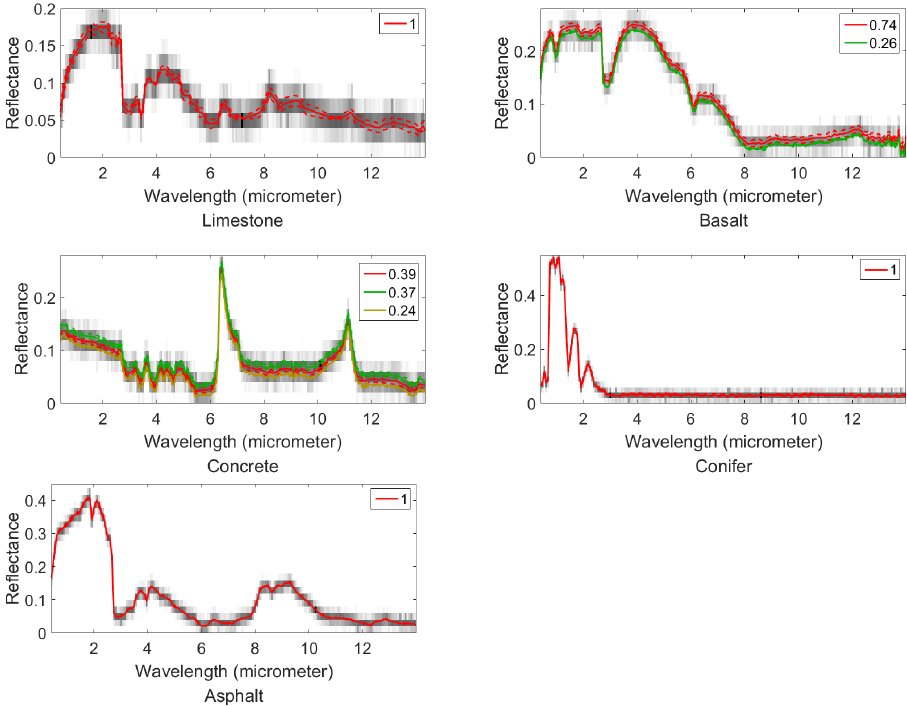
Figure 3. The endmember spectral signatures of the synthetic dataset. The gray portion of the background within the image represents the reflection value of the pure pixel reflectance at each wavelength position. The different colors in the figure represent different components, and the corresponding legend indicates its prior probability. The solid line indicates the center of Gaussians µ jk , and the dotted line indicates the variance range of each Gaussian component, which is constructed